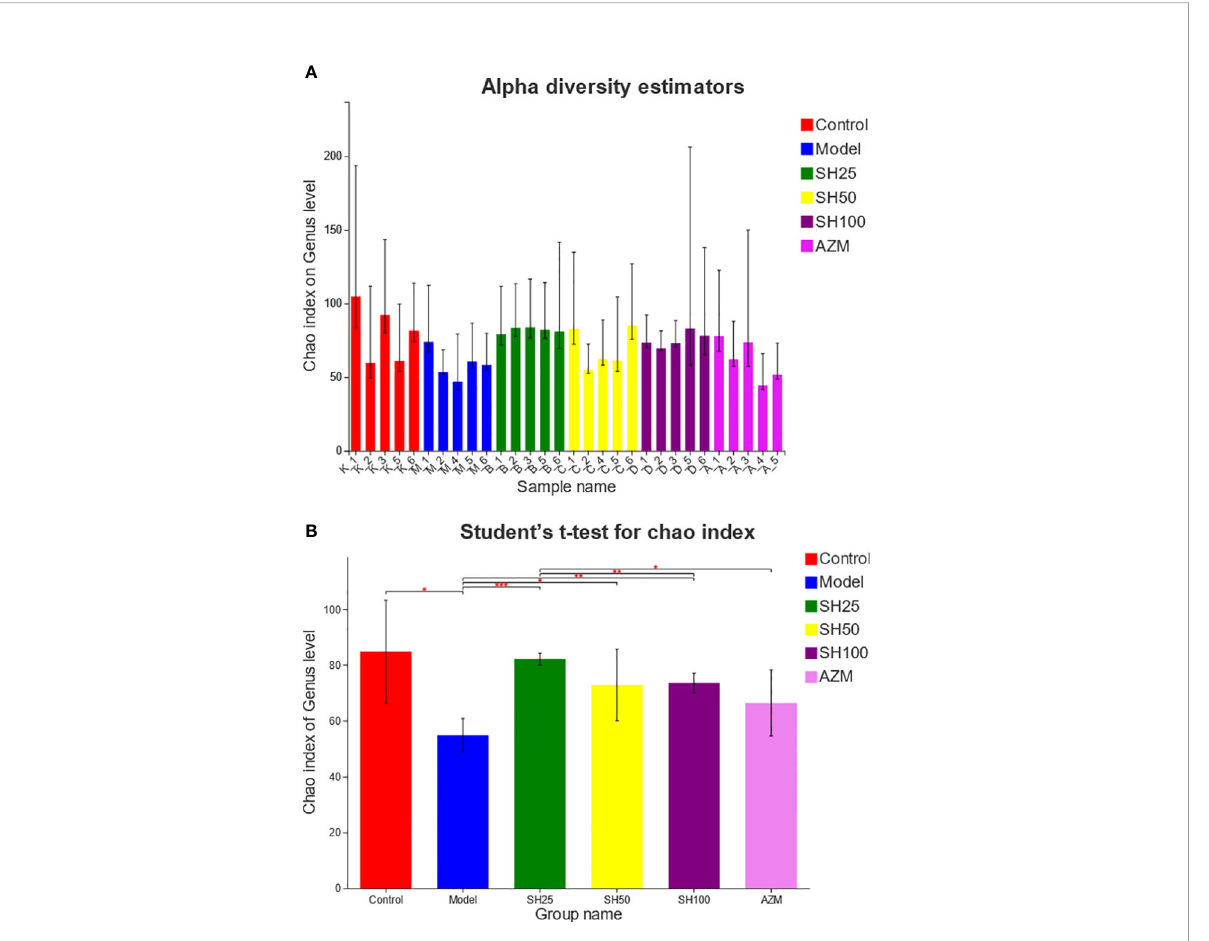
FIGURE 6 Alpha diversity analysis of gut microbiota. (A) Chao diversity index histogram. (B) Chao diversity test group t-test histogram. The X axe represents the group name, and The Y axe represents the exponential average of each group. *0.001<P ≤ 0.05, **0.001<P ≤ 0.01, ***P ≤